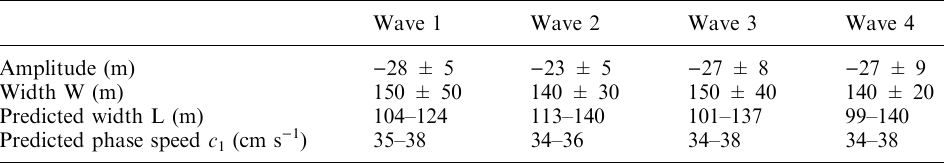
Wave 1 Wave 2 Wave